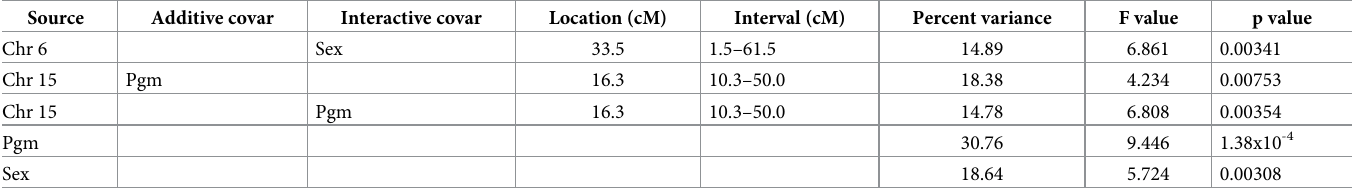
Table 4. Multiple regression model for the health sac phenotype in G59S-hDCTN1 mice. Source Additive covar